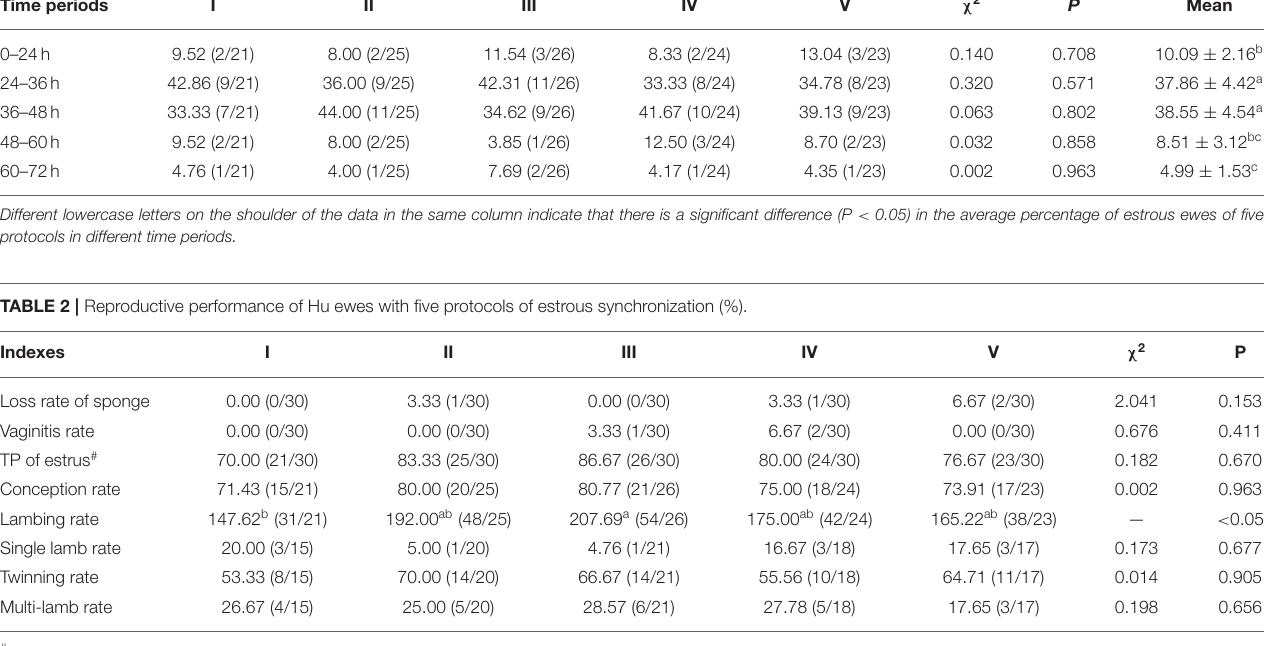
# “TP of estrus” represents “total percentage of estrous ewes”. The different lowercase letters on the shoulder of the data in the same row indicate that there is a significant difference in the lambing rate of ewes (P < 0.05) of five protocols of estrus synchronization.